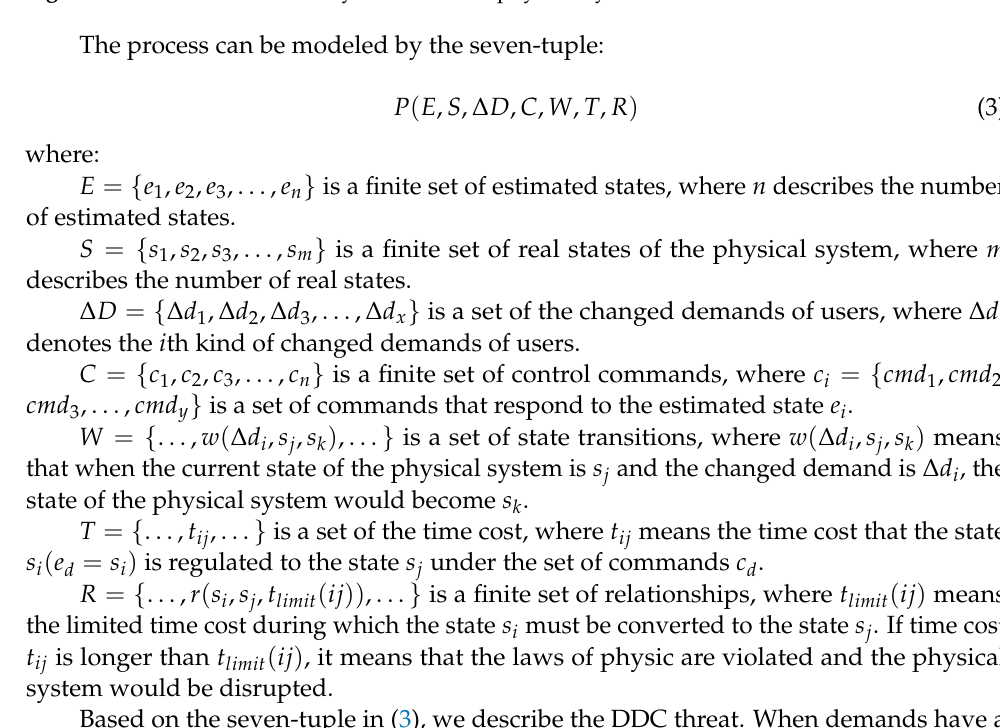
Figure 10. Process of the stability control of the physical